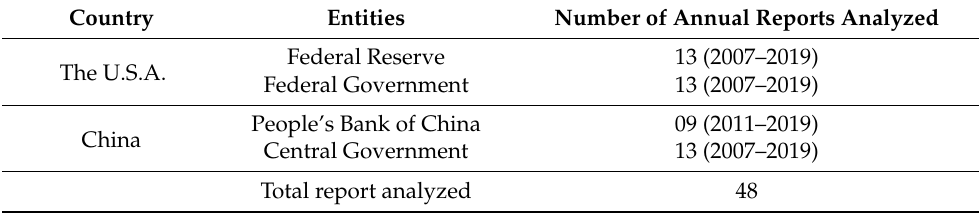
Country Entities Number of Annual Reports Analyzed The U.S.A.